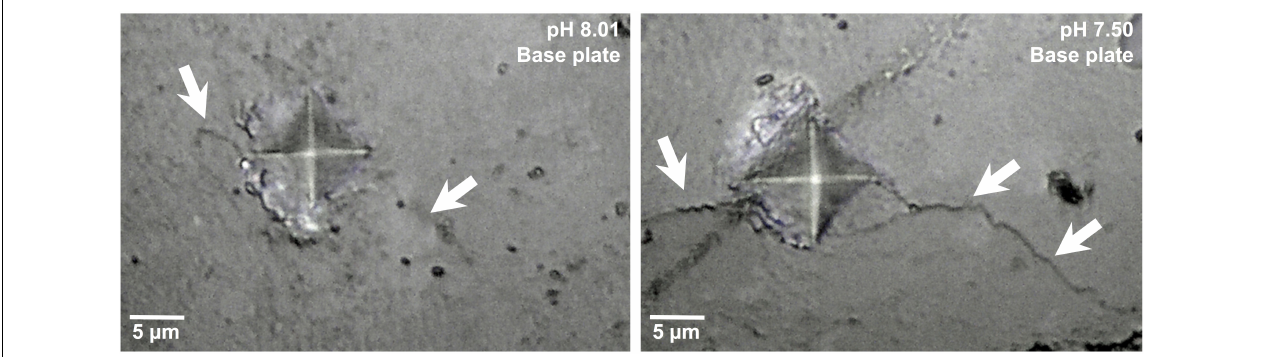
FIGURE 2 | Indents and cracks (arrows) resulting from mechanical testing within the base plate of a barnacle ( A. amphitrite ) held as pH 8.01 (left) and 7.50